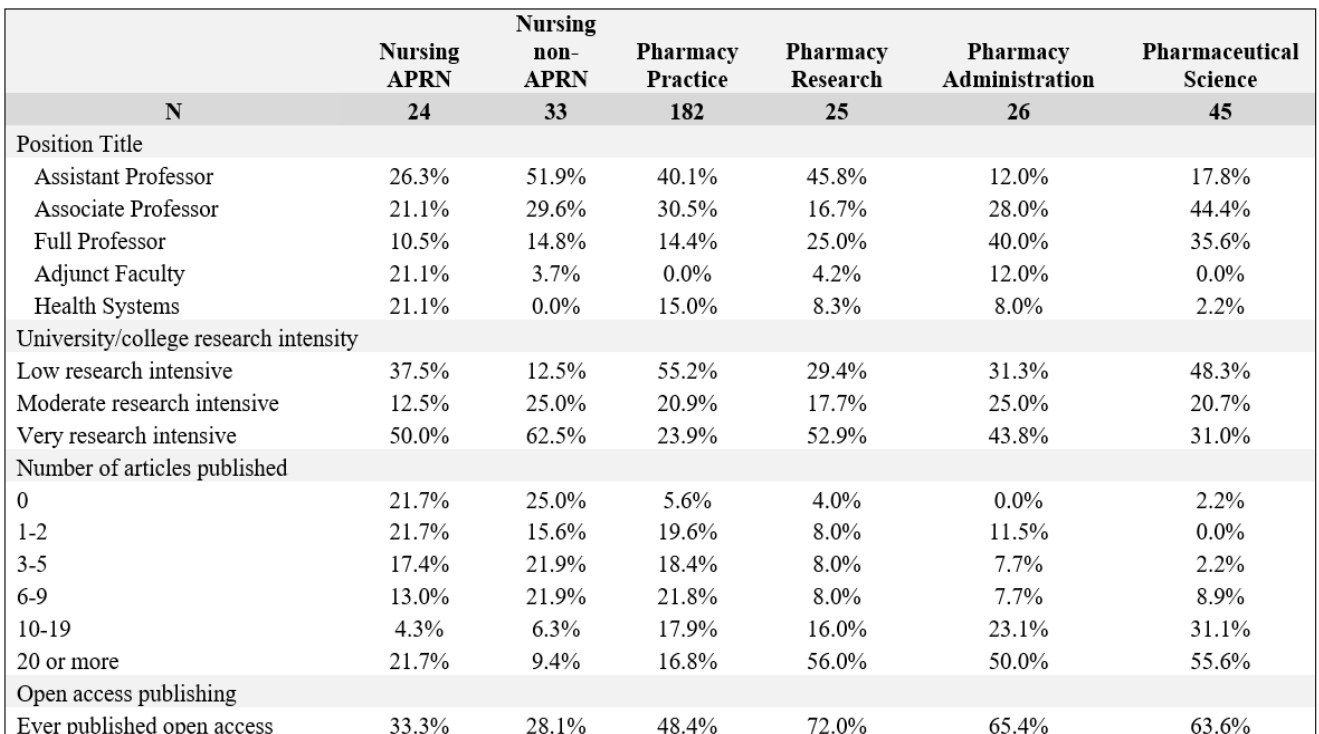
characteristics, 2020 Binghamton-Wilkes University Predatory Publishing Survey